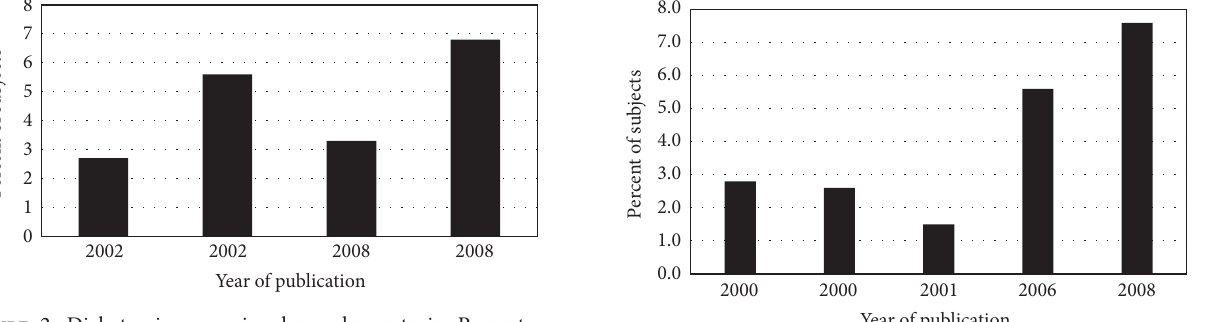
Figure 2: Diabetes in screening hemochromatosis. Percentages of participants in population-based screening studies discovered to have HFE p.C282Y homozygosity who reported that they had previous diagnoses of diabetes [115, 170–172]. There were two such reports from 2002 and two others from 2008. Hemochromatosis was also evaluated with iron phenotyping. In the respective populations, the prevalence of diabetes in p.C282Y homozygotes and control subjects did not differ significantly.